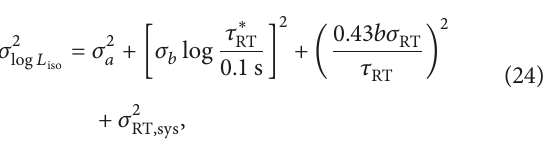
-log 𝜏 ∗ correlation with the best fit line. (Figure iso RT